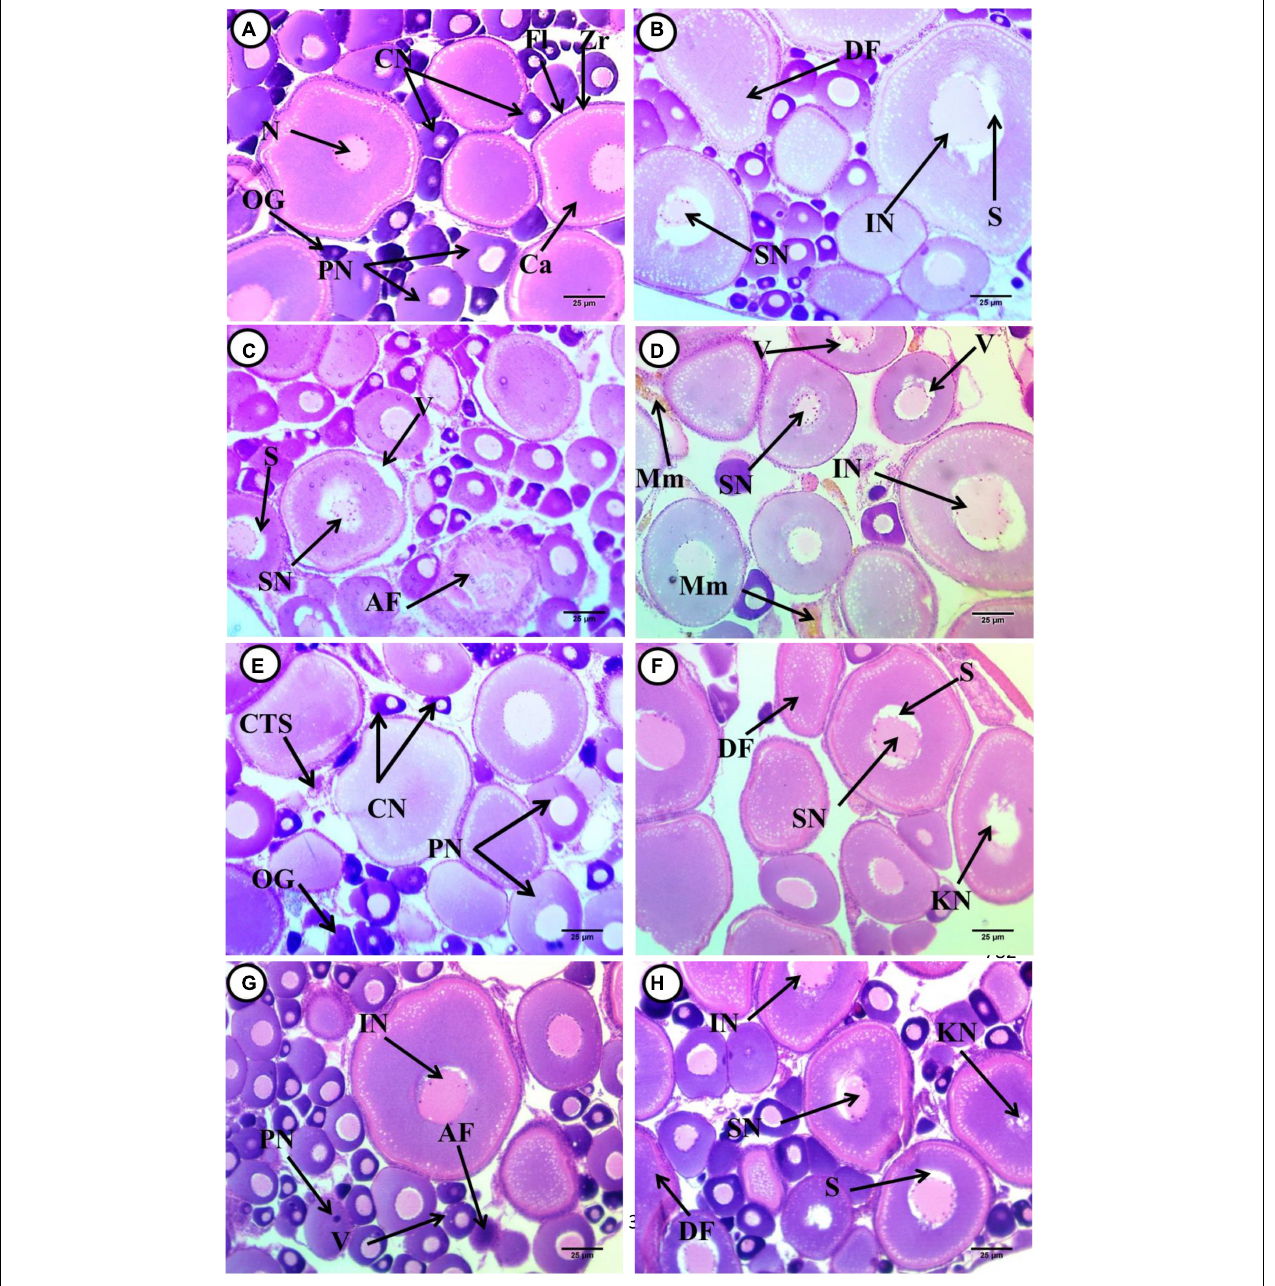
FIGURE 1 | Transverse sections of juvenile African catfish (C. gariepinus) ovary. (A) Control fish after exposure to 4-non-ylphenol (4-NP), (B) fish exposed to 0.1 mg/L 4-NP, (C) fish exposed to 0.2 mg/L 4-NP, (D) fish exposed to 0.3 mg/L 4-NP, (E) control fish after recovery period, (F) fish exposed to 0.1 mg/L 4-NP dose after the recovery period, (G) fish exposed to 0.2 mg/L 4-NP dose after the recovery period, and (H) fish exposed to 0.3 mg/L 4-NP dose after the recovery period, Oogonia (OG), chromatin nucleolar stage (CN), and perinucleolar stage (PN). Primary envelope (zona radiata) (Zr), follicular layer (Fl), cortical alveoli (Ca), nucleus consist of more than four nucleoli (N), deformed shape of cortical alveoli stage (DF), irregular nucleus (IN), unstained space around the nucleus (S) shrunken nucleus (SN), the atretic follicle (AF), vacuoles (V) and shrunken nucleus (SN), vacuoles (V), irregular nucleus (IN) and Melanomacrophage centers (Mm), karyolitic nucleus (KN), and pyknotic nucleus (PN). (H&E × 400).